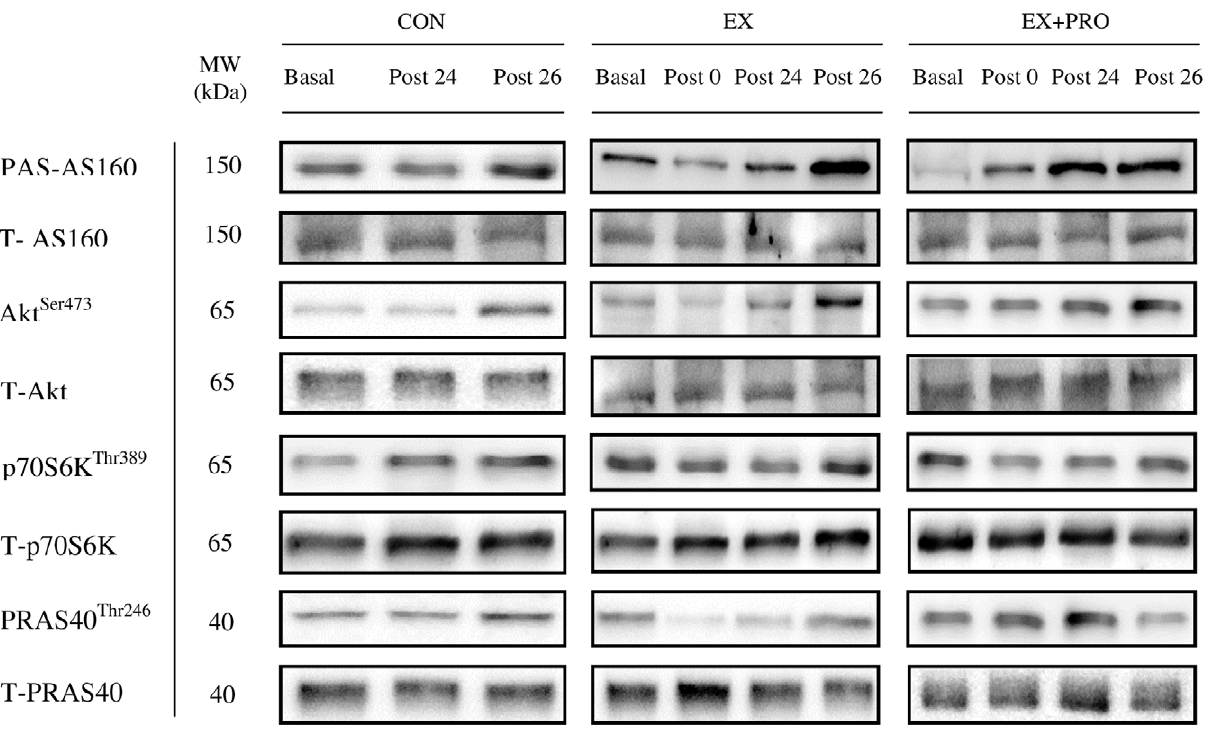
Figure 7. Representative protein phosphorylation blots. Proteins phosphorylation was studied in the basal, fasted state (Basal), immediately post-exercise (Post 0), 24 h post-exercise (Post 24) and 26 h post-exercise following the OGTT (Post 26) and normalized to total protein content.